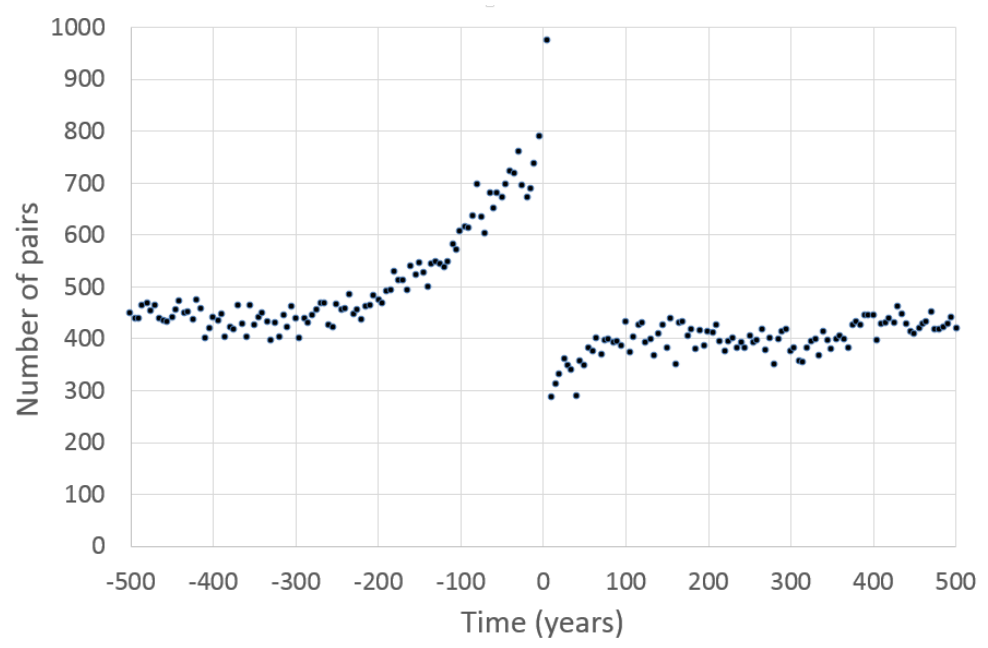
Figure 4. Stacked number of M ≥ 4.2 earthquakes that preceded and followed an M ≥ 5.2 earthquake within an epicentral distance of 20 km in the 100,000 years simulated